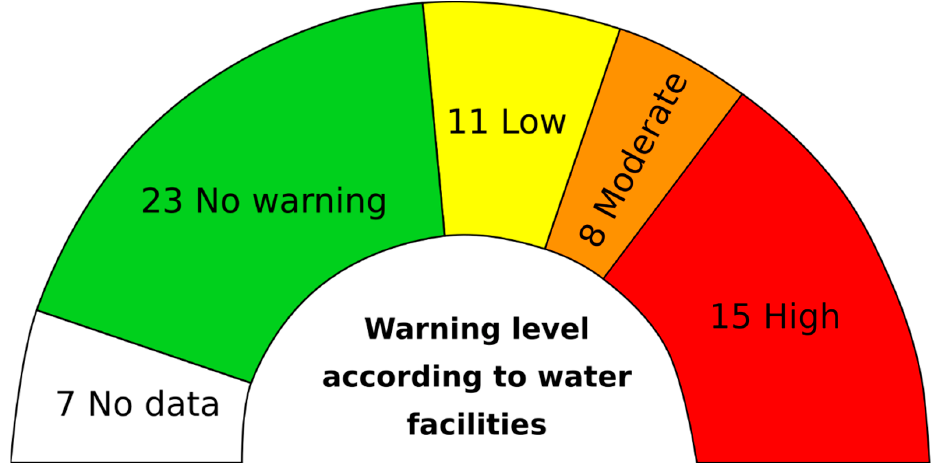
Figure 10. Classification of object warning levels after one year of testing (object/given category).